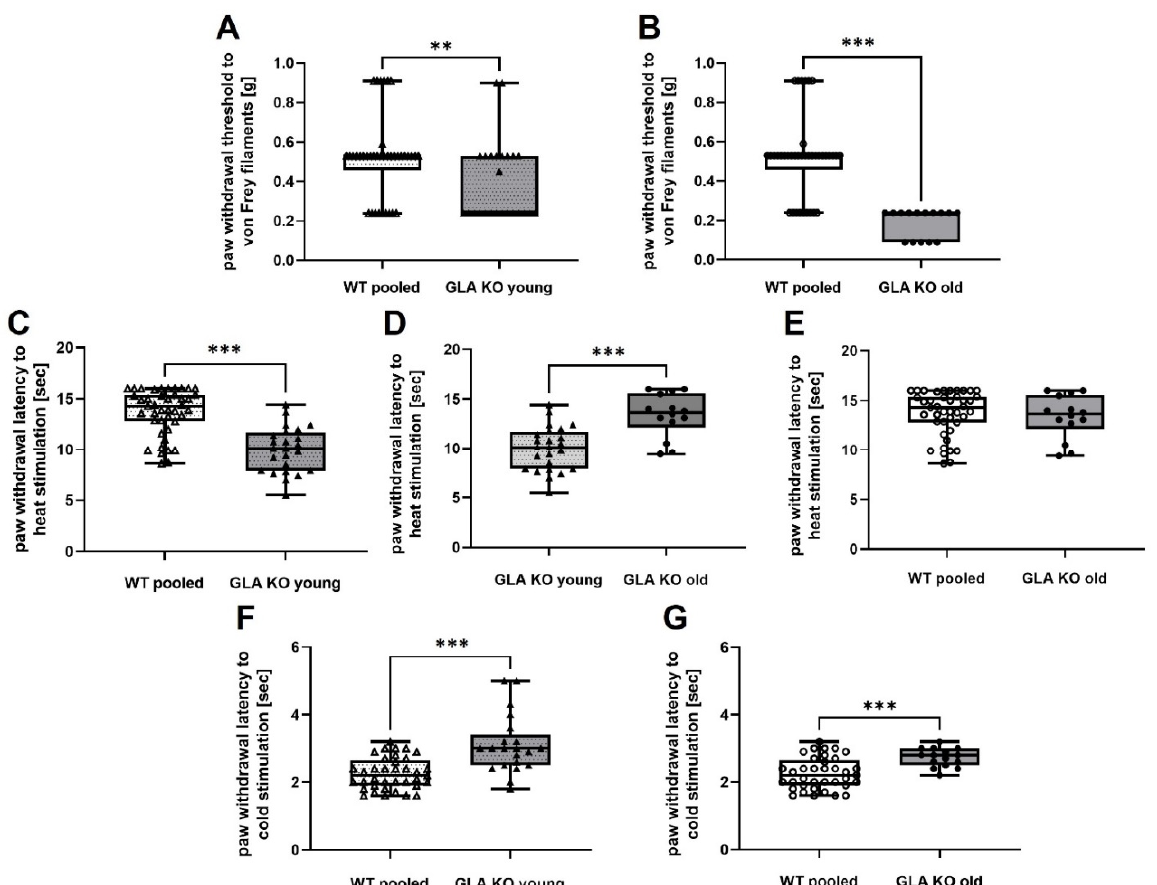
Figure 8. Behavioral analysis of pooled WT mice and young and old GLA KO mice including von Frey test, Hargreaves test, and cold sensitivity test. ( A ) Von Frey testing of pooled WT mice ( , n = 38) and young GLA KO mice ( , n = 25). ( B ) Von Frey testing of pooled WT mice ( , n = 38) and old GLA KO mice ( , n = 15). ( C ) Hargreaves testing of pooled WT mice ( , n = 43) and young GLA KO mice ( , n = 24). ( D ) Hargreaves testing of young ( , n = 24) and old ( , n = 14) GLA KO mice. ( E ) Hargreaves testing of pooled WT mice ( , n = 43) and old GLA KO mice ( , n = 14). ( F ) Cold sensitivity testing of pooled WT mice ( , n = 37) and young GLA KO mice ( , n = 21). ( G ) Cold sensitivity testing of pooled WT mice ( , n = 37) and old GLA KO mice ( , n = 15). Abbreviations: g = gram; GLA KO = alpha-galactosidase A knockout; sec = seconds; WT = wildtype. ** p < 0.01, *** p < 0.001.